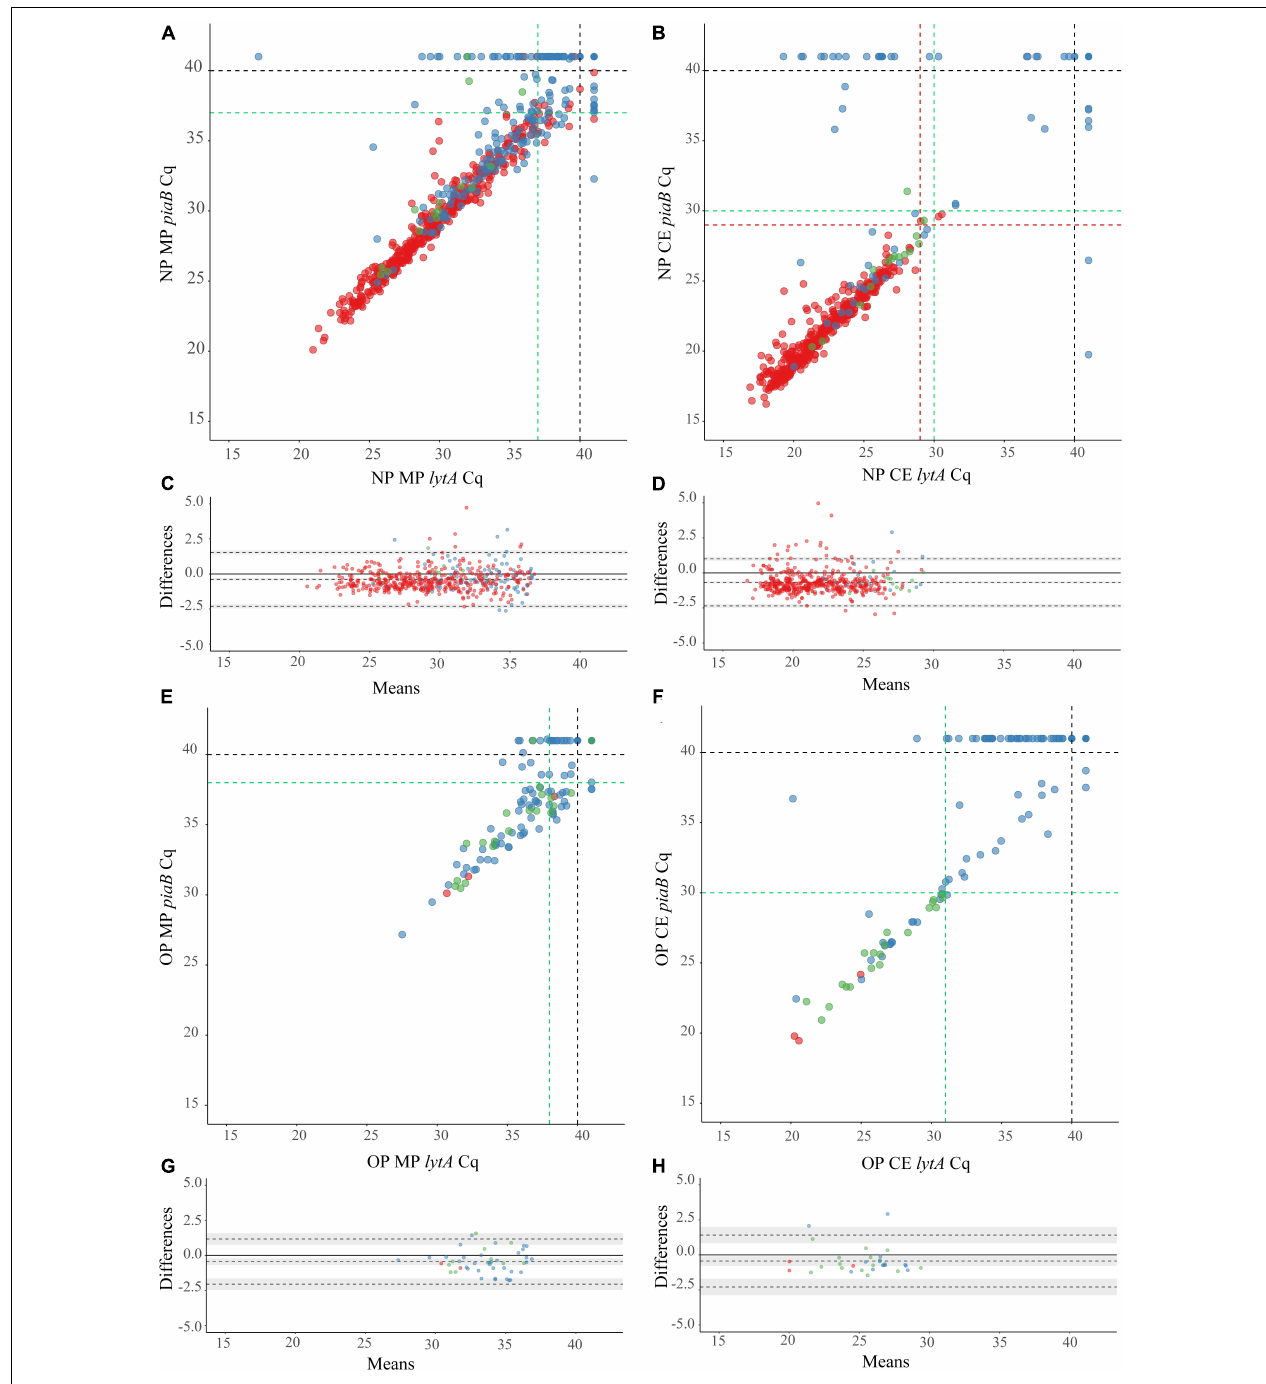
FIGURE 3 | Scatter plots (A,B,E,F) displaying correlation between cycle threshold (C q ) from qPCR assays targeting the Streptococcus pneumoniae genes piaB and lytA for minimally processed (A,E) and culture-enriched (B,F) nasopharyngeal (A,B) and oropharyngeal (E,F) samples followed by the Bland-Altman plots (C,D,G,H) displaying agreement between piaB and lytA for samples positive with minimally processed (C,G) and culture-enriched (D,H) ROCd C q criteria in nasopharyngeal (C,D) and oropharyngeal (G,H) samples. The shaded gray areas in (G,H) mark the 95% confidence interval of the upper limit of agreement, bias and lower limit of agreement. The Bland-Altman plots show the absence of systematic bias between piaB and lytA because the line of equality (solid line) is within the limits of agreement. Bias between piaB and lytA is more often observed in high C q samples. Primary culture-positive and qPCR-guided culture-positive samples are indicated with red and green dots, respectively. Culture-negative samples are indicated with blue dots. In (A,B,E,F) black dashed lines indicate the arbitrary C q criterium ( < 40 C q ), green dashed lines indicate ROCd C q criteria derived by validating qPCR results with primary and qPCR-guided cultures results. Red dashed lines in (B) indicate ROCd C q criteria derived by validating qPCR results with primary culture alone. In (A) red lines overlap with green lines and only the latter are shown.